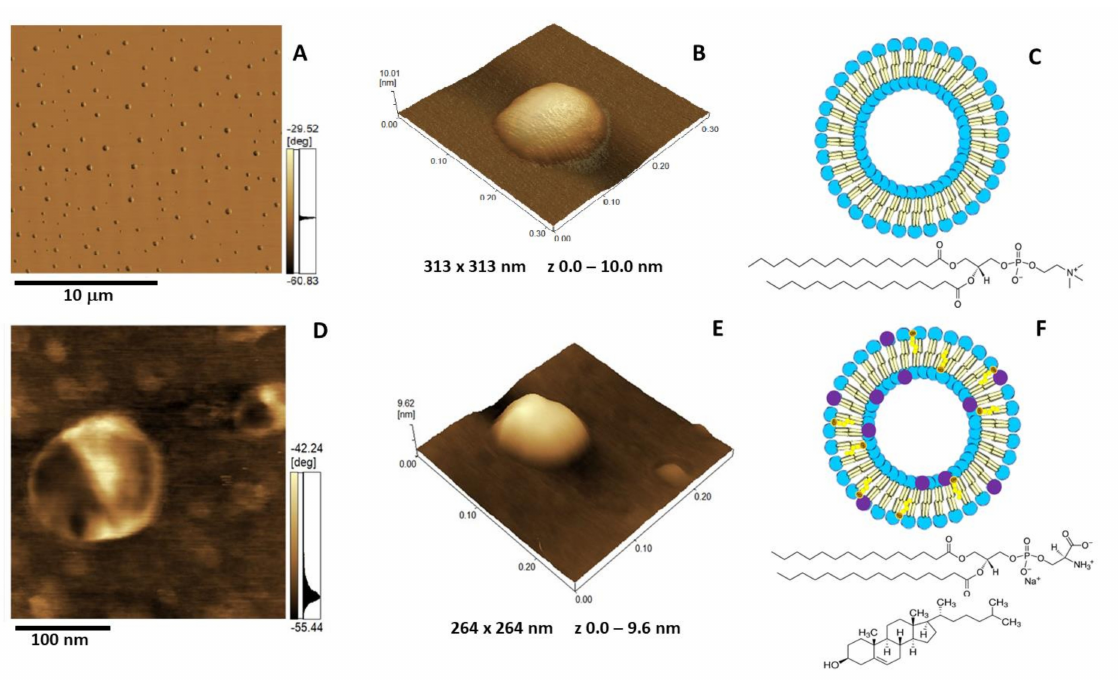
Figure 5. Atomic force microscopy (AFM) images of DPPC ( A – C ) and 5:4:1 DPPC:Chol:DPPS ( D – E ) liposomes (1.5 mg / mL): ( A , D ) Phase image, ( B , E ) 3D topography, and ( C , F ) liposome schematic representation. The blue and purple circles in C and F are assigned to the polar heads of DPPC and DPPS, respectively. The brown and yellow colors are assigned to Chol. The chemical structure of DPPC is depicted in C , and the chemical structures of DPPS and Chol are depicted in F .